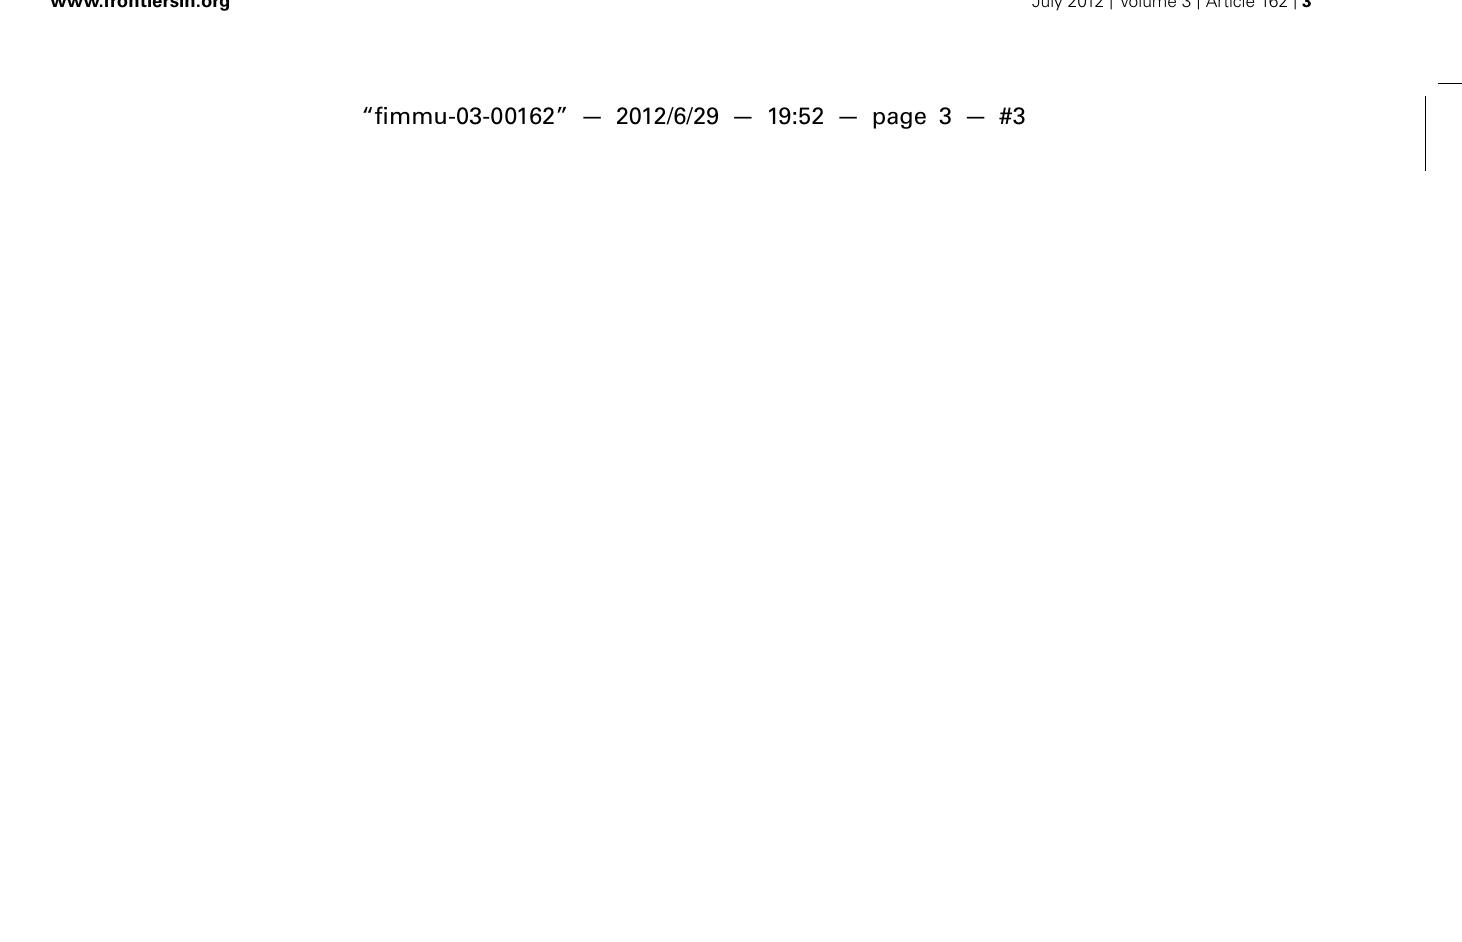
kidney function partially recovered. Sirius red staining shows (A) normal mouse kidney and (B) severe fibrosis 3 weeks after the mouse underwent 25 min of warm renal I/R injury (Representative images, unpublished